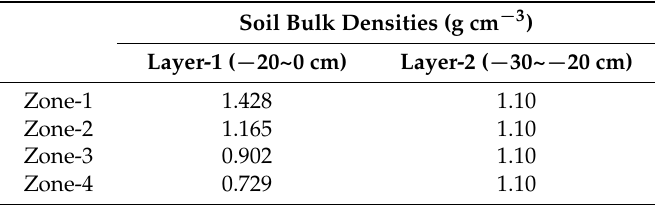
Table 1. Soil bulk densities preparation for Layer-1 and Layer-2 at Zones-1, -2, -3 and -4.